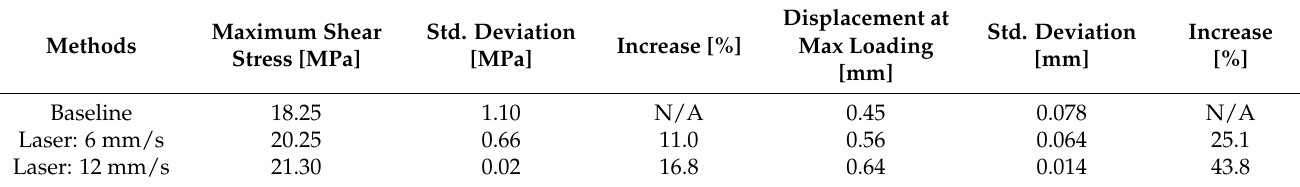
Figure 14. Shear strength ( left ) and displacement at maximum loading ( right ) for the laser-structured specimens and baseline (A: Baseline; B: 6 mm/s; C: 12 mm/s). Table 6. Statistics and percentage increase in the maximum shear stress and maximum displacement for the laser-structured specimens with respect to the baseline.